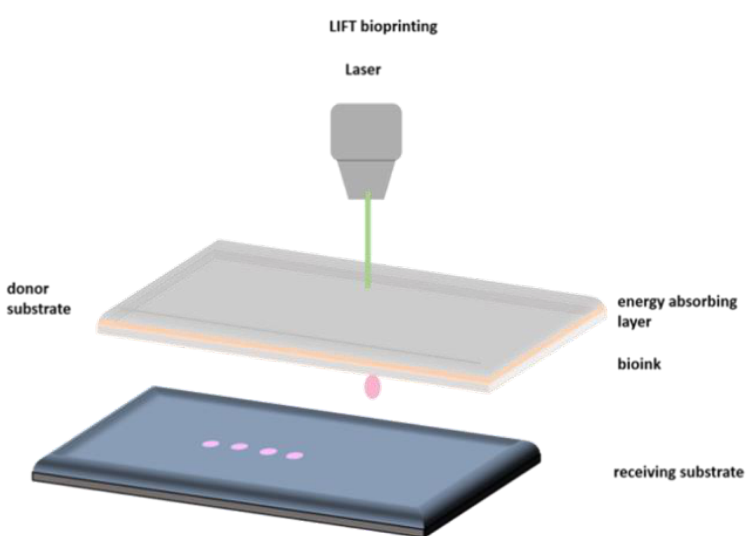
Figure 1. Schematic representation of laser-induced forward transfer (LIFT) setup.